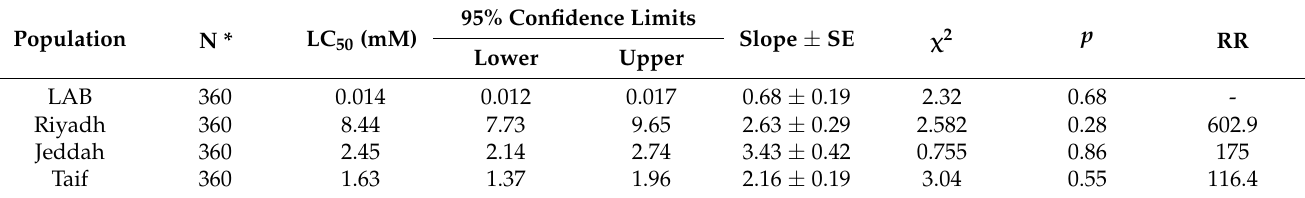
Table 1. Pirimiphos-methyl median lethal concentration (LC 50 ) values and resistance ratios (RR) of Musca domestica .